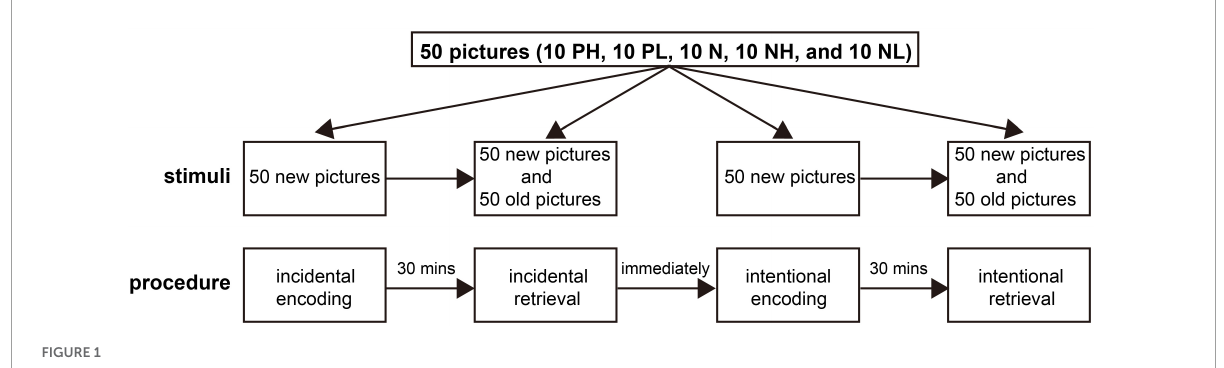
FIGURE1 The procedure of the emotional memory paradigm.